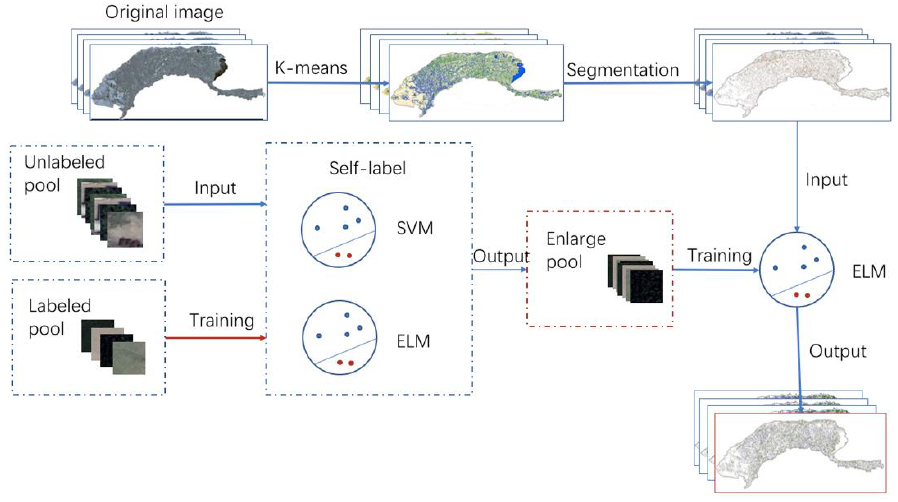
Figure 3. Flowchart of the semi-supervised extreme learning machine (SS-ELM) framework. Table 2. The procedure of the co-training self-label algorithm